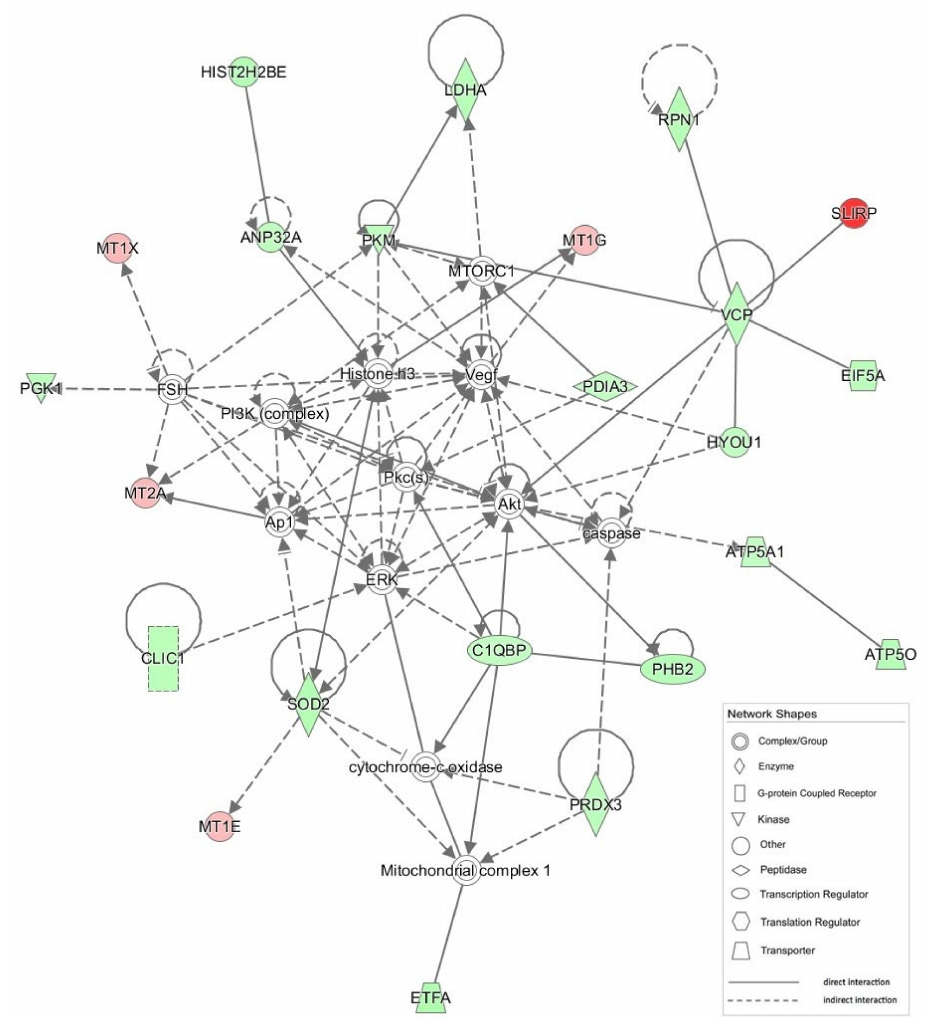
Figure 10. Graphical representation of the most significant IPA network (network # 1, score 51). Mitochondrial CI is in a pivotal position, for which a number of direct and indirect interactions are shown with different proteins modulated by